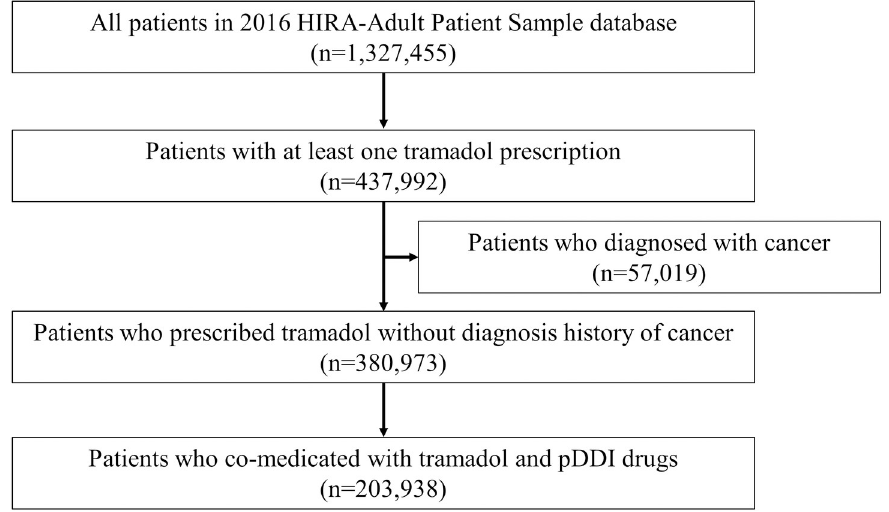
Fig 1. Selection of study participants from 2016 HIRA-adult patient sample database. pDDI, potential drug-drug interaction.